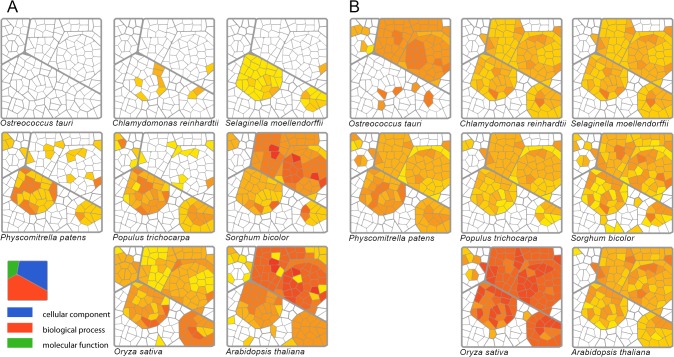
Voronoi treemap representation of the GO term enrichment study.(A) GO fingerprints of proteins of putative cyanobacterial origin of the eight species. A gradual invasion of the GO space by cyanobacterial recruits demonstrates the non-random nature of the GO terms distribution. This suggests a selection-driven gene transfer. (B) GO fingerprints of nuclear proteins with plastid homologues of the same eight species. No particular space is occupied by significant terms on any of the maps, which indicates that the nucleus acts as a DNA sink in all species, attracting genes in a wide range of GO terms.